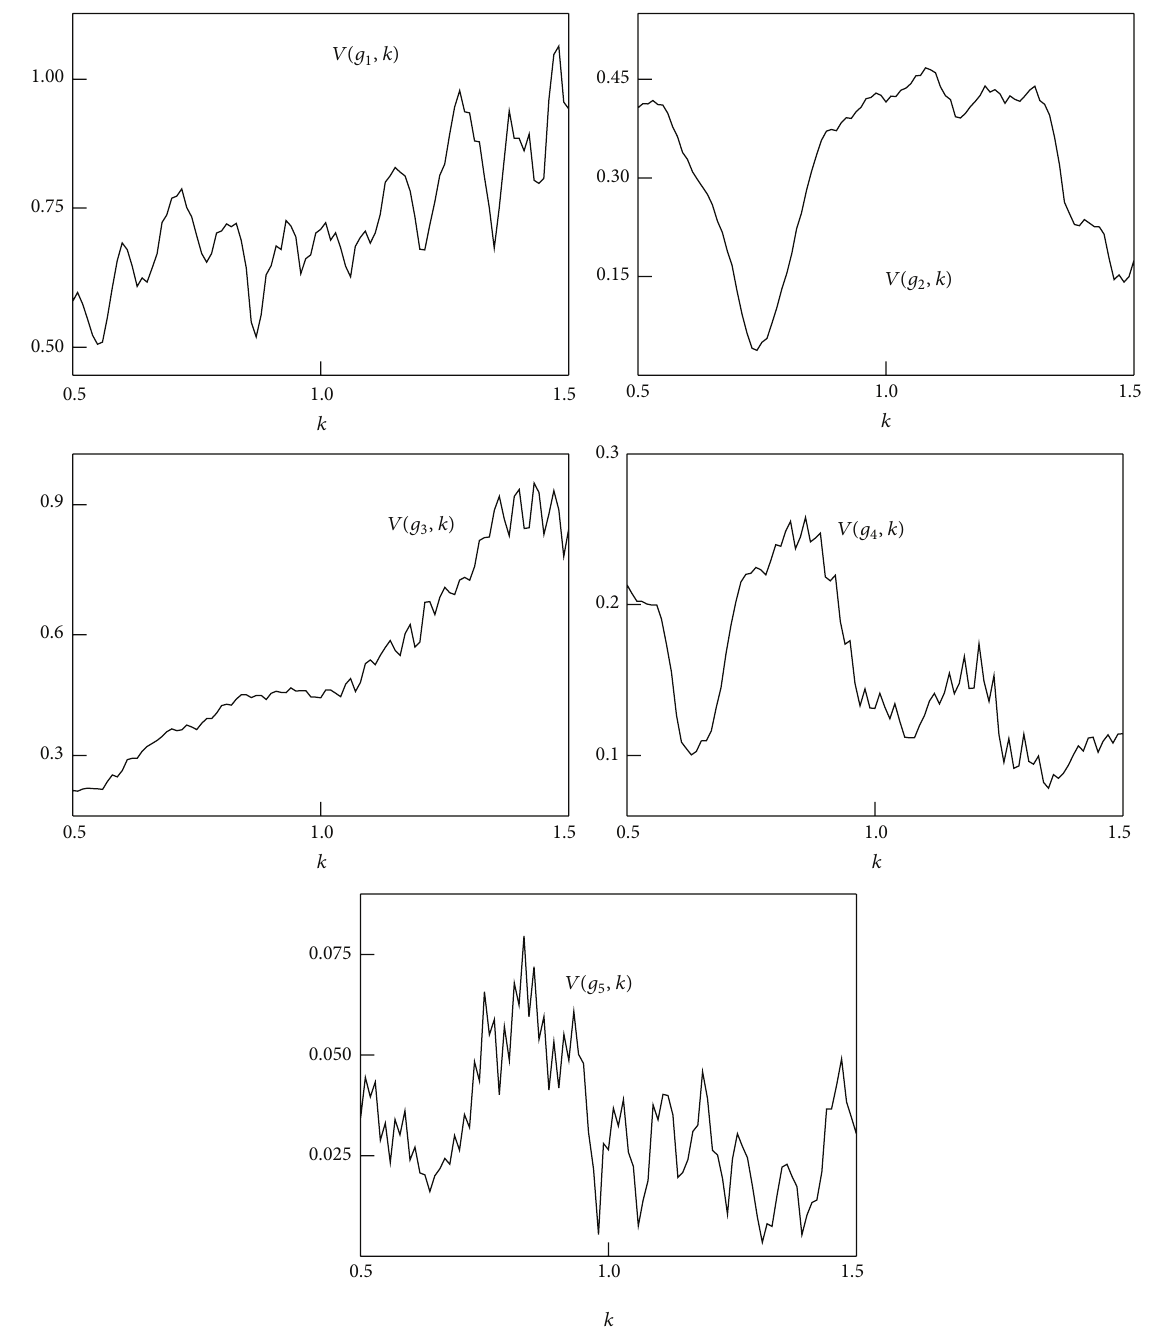
Figure 3: The magnitudes of 𝑉(𝑔 𝑗 , 𝑘) obtained in different points 𝑔 𝑗 ∈ Ω int